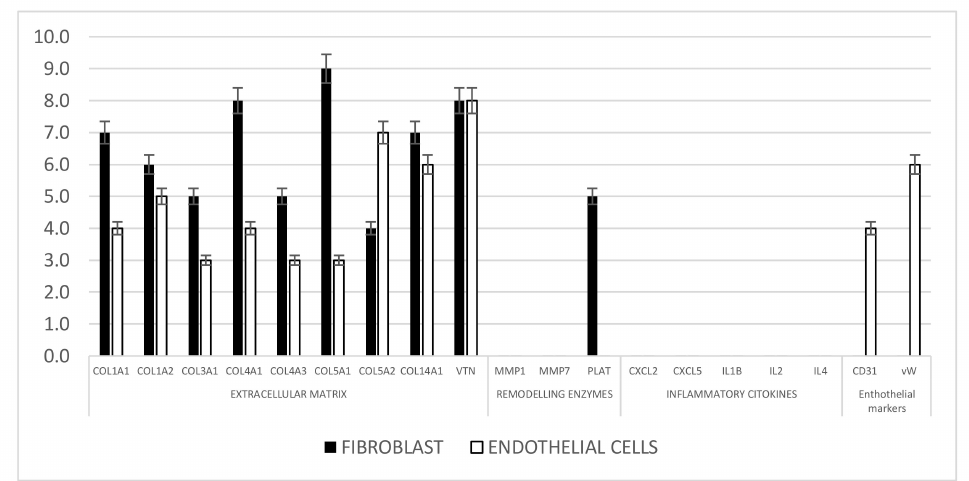
Figure 10. Real-time PCR analysis of extracellular matrix and remodeling enzymes markers in Fibroblast and endothelial cells cultured on PCL electrospun surfaces. Results for each experiment are obtained from triplicate experiments and values are expressed as the mean ±